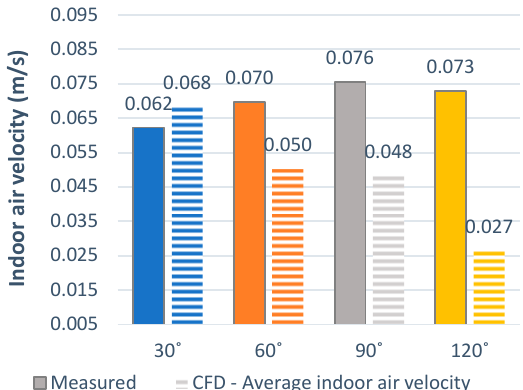
Figure 12. Measured air velocity in the living room with CFD average indoor air velocities (m/s) calculated at a horizontal plane-1.2 m above the floor (only valid wind directions).